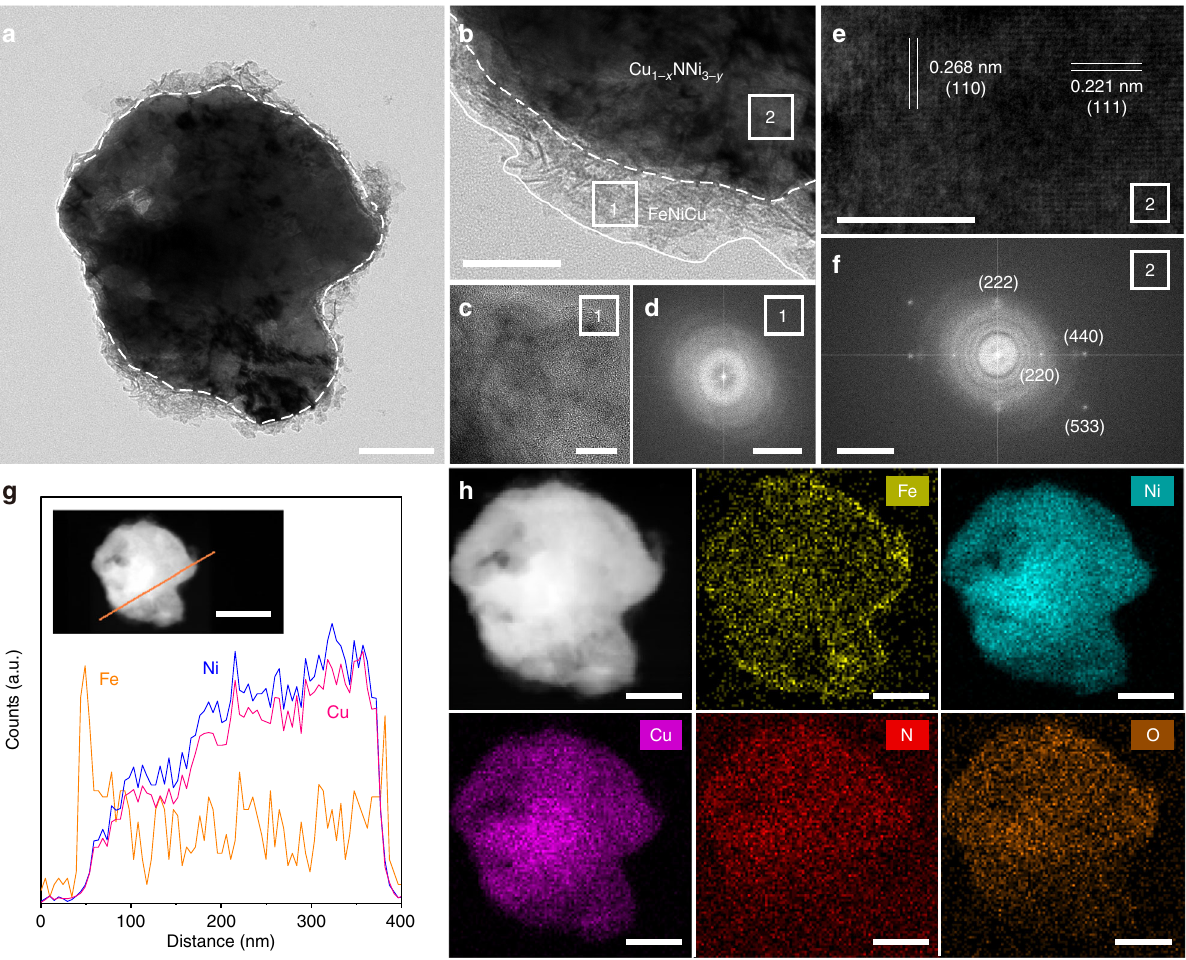
Fig. 3 Morphology and texture characterization. a TEM and b magni fi ed TEM images of p-Cu 1 − x NNi 3 − y /FeNiCu. c HRTEM and d the corresponding FFT images of the FeNiCu shell. e HRTEM and f the corresponding FFT images of the Cu 1 − x NNi 3 − y core. g Line-scan EDS spectra and h STEM-EDS element mapping images of the p-Cu 1 − x NNi 3 − y /FeNiCu. Scale bar in a is 100 nm, in b is 50 nm, in c is 10 nm, in d is 5 nm − 1 , in e is 5 nm, in f is 5 nm − 1 , in g is 200 nm and in h is 100